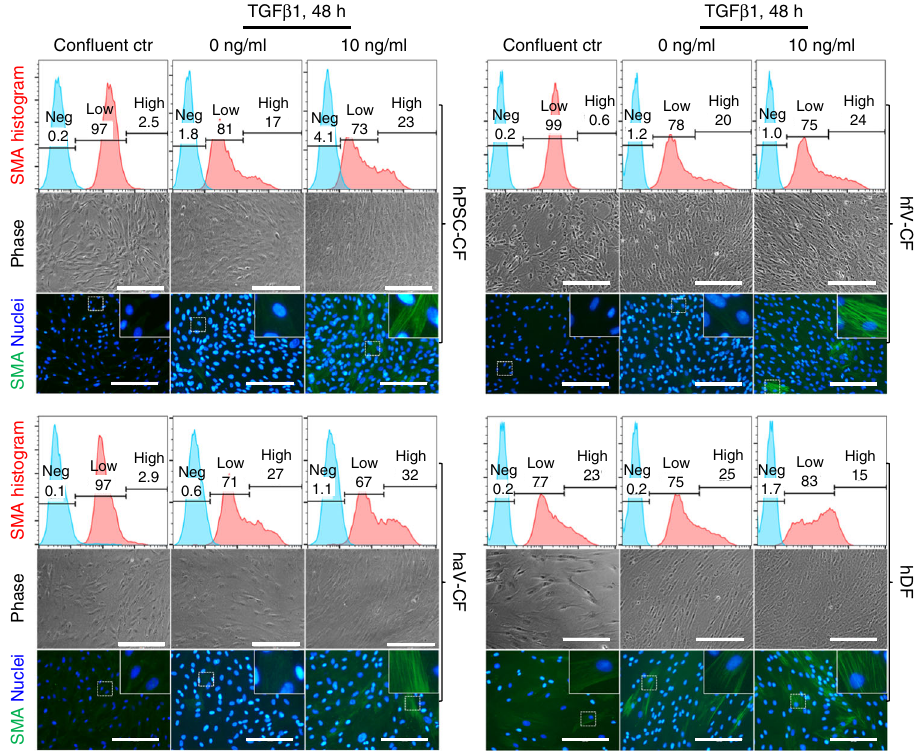
Fig. 9 Myo fi broblast transformation of CFs and DFs. Analysis of α -smooth muscle actin (SMA) expressing cells to assay for myo fi broblast transformation from hPSC-CF, hfV-CF, haV-CF, and hDF in culture. All fi broblast cultures in passages 4 – 6 were treated with 10 ng/ml TGF β 1 for 48 h in DMEM + 10% FBS medium. Expression of SMA was measured by both fl ow cytometry (upper panel) and immunolabeling (lower panel). Phase contrast images of representative cultures are shown in the middle panel. Phase contrast images and SMA immuno fl uorescence images are from the same biological samples, but not the same fi eld of view. Scale bars are 200 μ m. The hPSC-CFs are derived from DF19-9-11T hiPSCs. The hfV-CFs are from Cell Applications, Inc. The haV-CFs are from Lonza, NHCF-V, and hDFs are from 023a